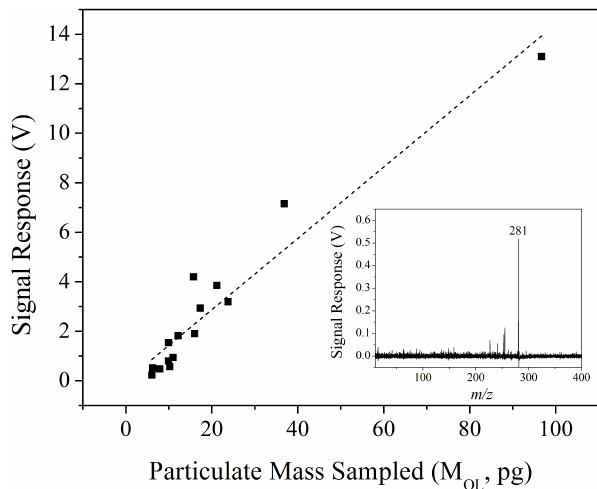
Fig. 2. Calibration curve for pure oleic acid particles (geometric mean diameter and standard deviation of 180nm and 1.3, respec- tively). Equation of line is S=0.144M OL − 0 . 0113. Black squares represent single measurements taken. Inset: NIR-LDI-AMS spec- trum of oleic acid particles sampled from an aerosol with mass load- ing of 0.15µgm − 3 for 30s (7.5pg total mass